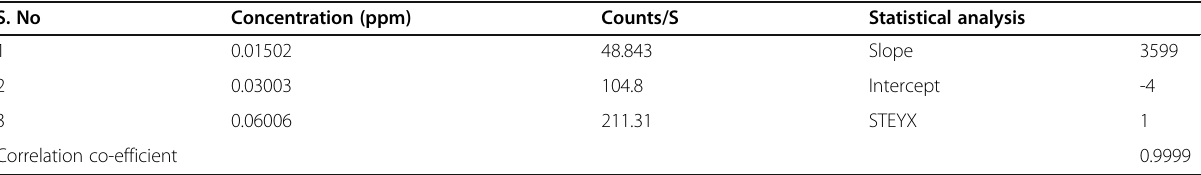
Table 11 System suitability results of Lead